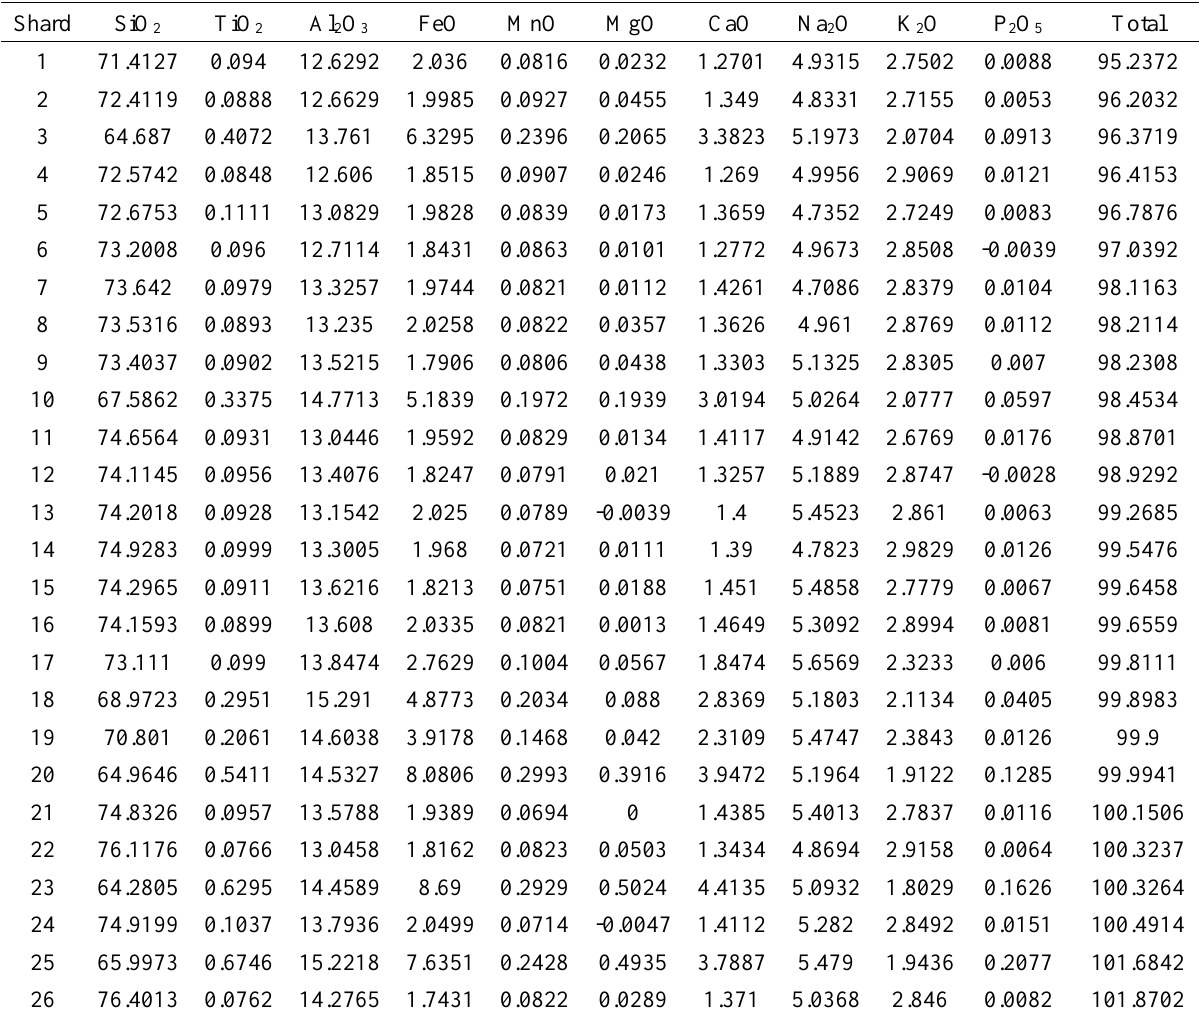
Table A3. Geochemistry from electronmicroprobe analysis of tephra shards found in the Braehour open core at 102 cm, identified as Hekla